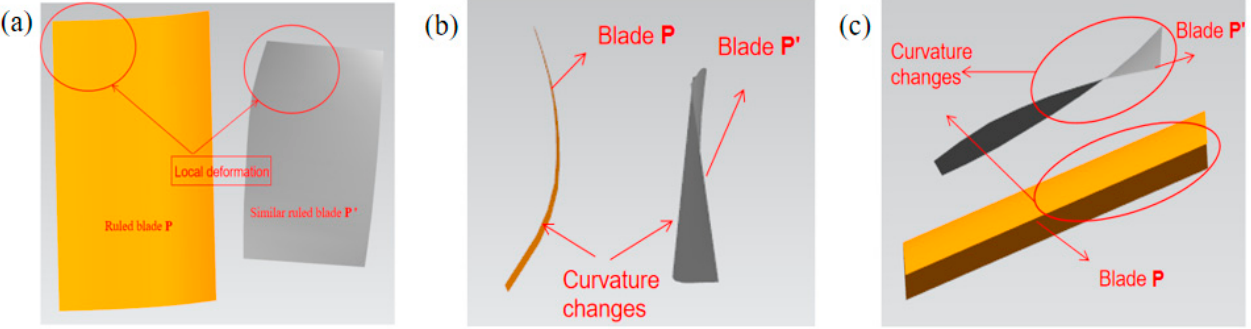
Figure 4. Three-dimensional model of two similar blades: ( a ) local deformation of similar blades, ( b ) vertical view of similar blades, ( c ) side view of similar blades.